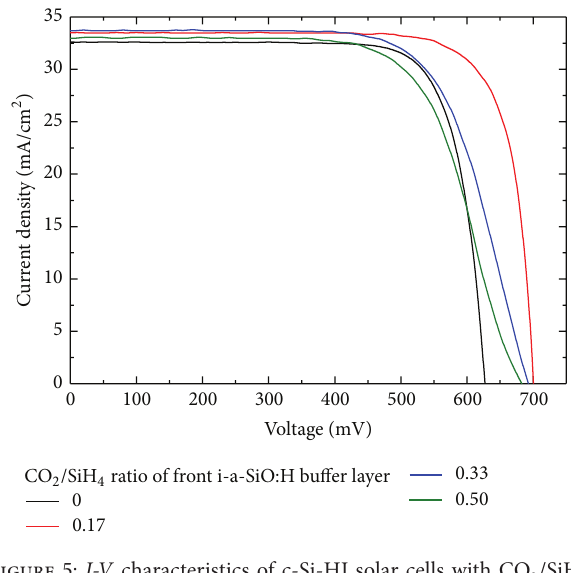
Figure 5: I-V characteristics of c-Si-HJ solar cells with CO 2 /SiH 4 ratio in front i-a-SiO:H buffer layer.